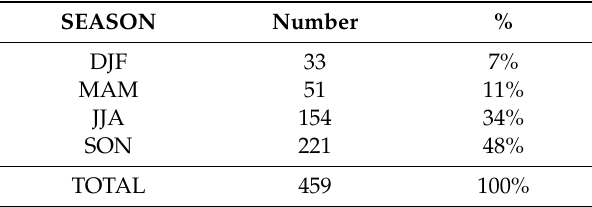
Table 2. Events number for season.